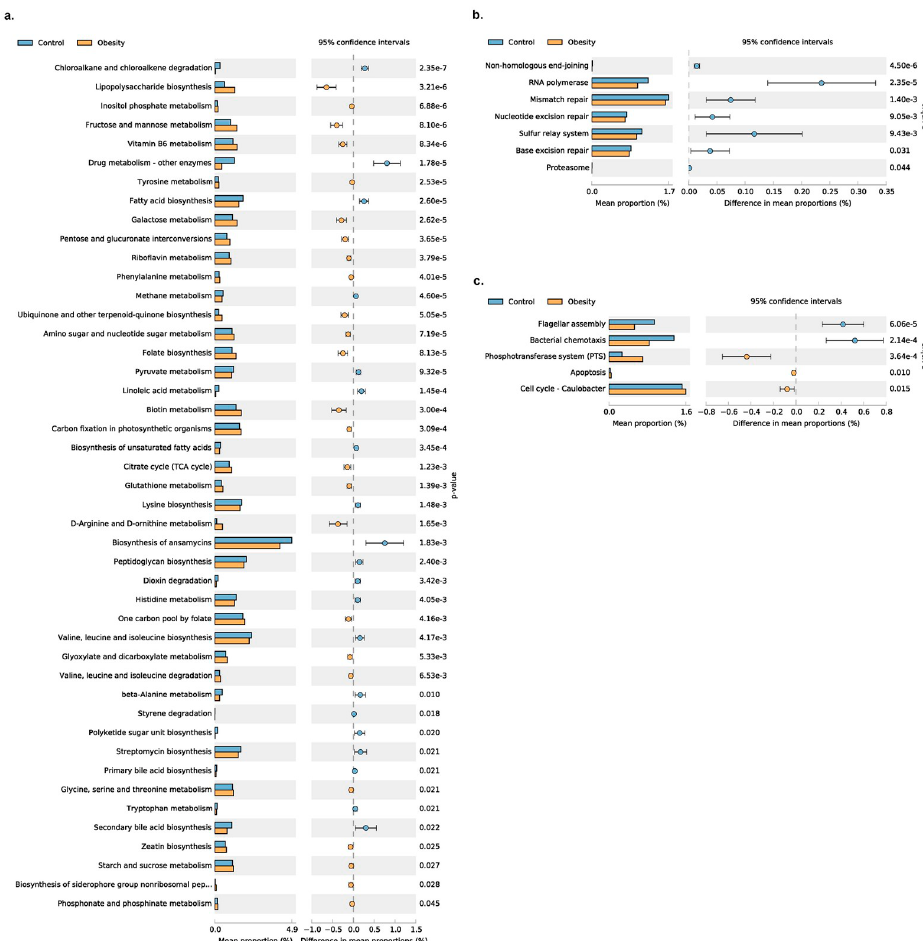
Fig 8. Predict the functional potential changes between obesity and control by using PICRUSt2. Panel a shows the changes of 45 pathways belonging to Metabolism between the Obesity and Control group. Panel b shows the changes of 7 pathways belonging to Genetic Information Processing between the Obesity and Control group. Panel c shows the changes of 5 pathways belonging to Environmental Information Processing and Cellular Processes between the Obesity and Control